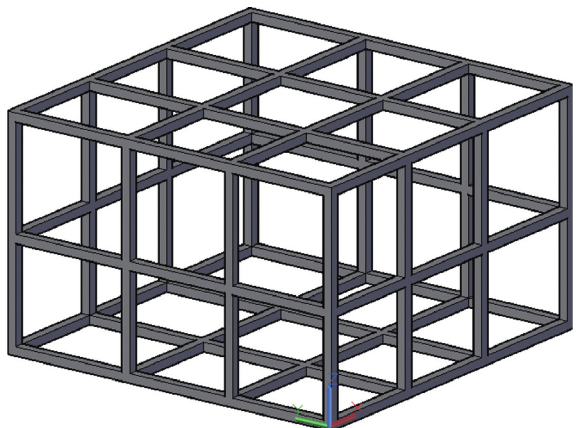
Figure 6: Schematic diagram for the frame.